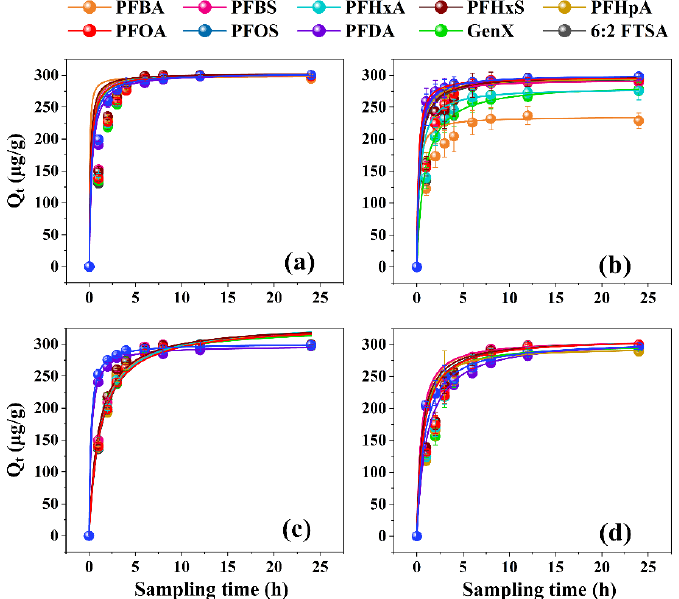
Figure 2. Pseudo-second-order model curve for the adsorption of PFASs onto different resins: ( a )